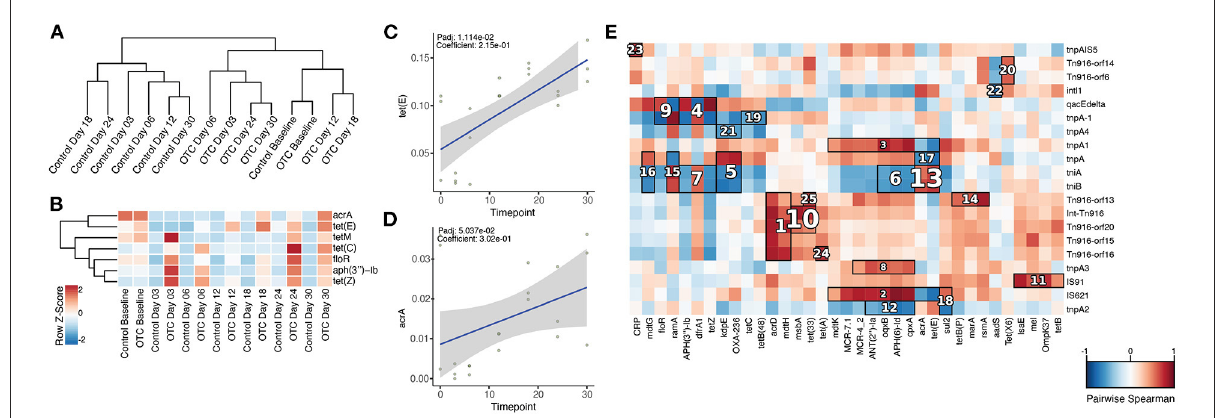
FIGURE5 Composition of antibiotic resistance genes and their association with mobile genetic elements in the zebrafish gut microbiome. (A) Dendrogram based on the composition of ARGs indicates that the samples from control and OTC exposure groups clustered separately. (B) Relative abundance of the ARGs identified to be highly abundant in the OTC exposure group. (C,D) tet(E) and acrA showed significant positive correlation with the duration of exposure to OTC. (E) The hallagram shows clusters of significantly correlated antibiotic resistance genes and mobile genetic elements. Correlations were computed using Spearman’s coefficient, Benjamini and Hochberg false discovery rate (FDR) controlling procedure was performed for the correction of P values ( P adj) and only P adj < 0.1 was considered statistically significant. Clusters are ranked according to their significance ( P adj) i.e., 1 represents the most significant correlation and vice versa. Here, only top 25 correlation clusters are shown while non-significant correlations and clusters are masked.